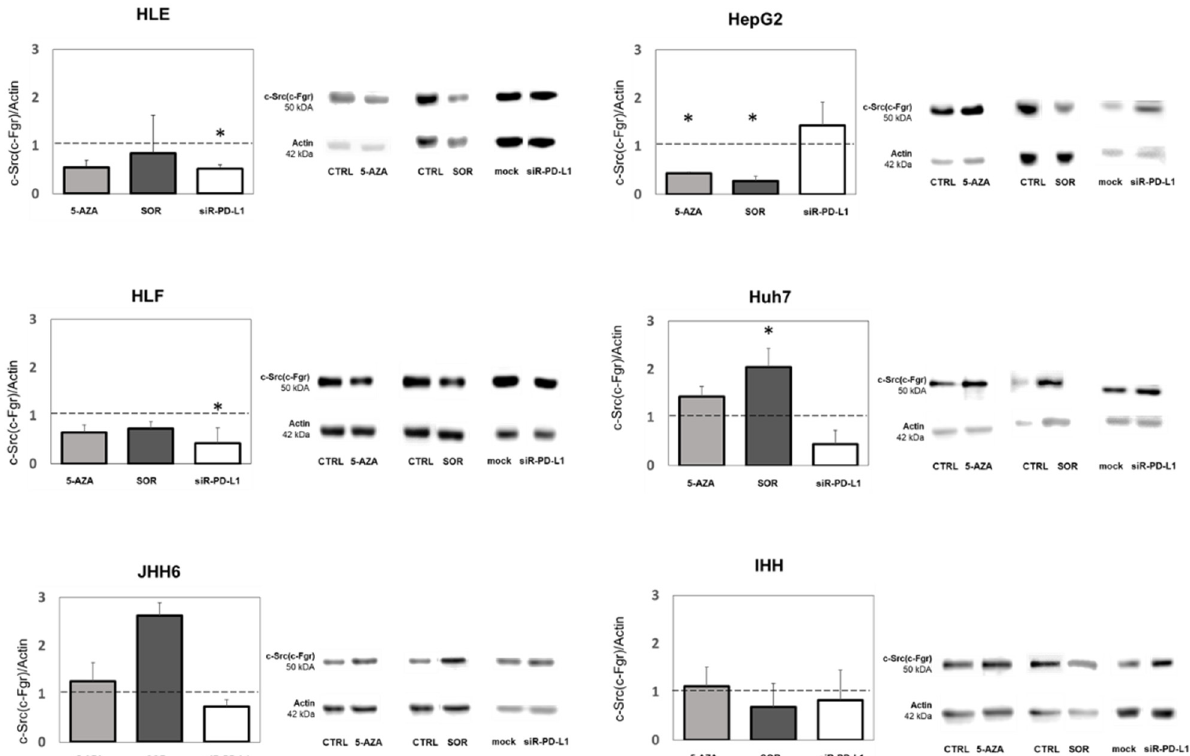
Figure 5. c-Src (c-Fgr) protein expression and its representative immunoblots among different HCC cell lines after treatment with 5-AZA, SOR and siR-PD-L1. Statistical analysis: * p < 0.05, Student’s t -test against CTRL or mock (=1.00; shown as dashed line). Actin (42 kDa) was used as a housekeeping protein against the c-Src (c-Fgr) (50 kDa).